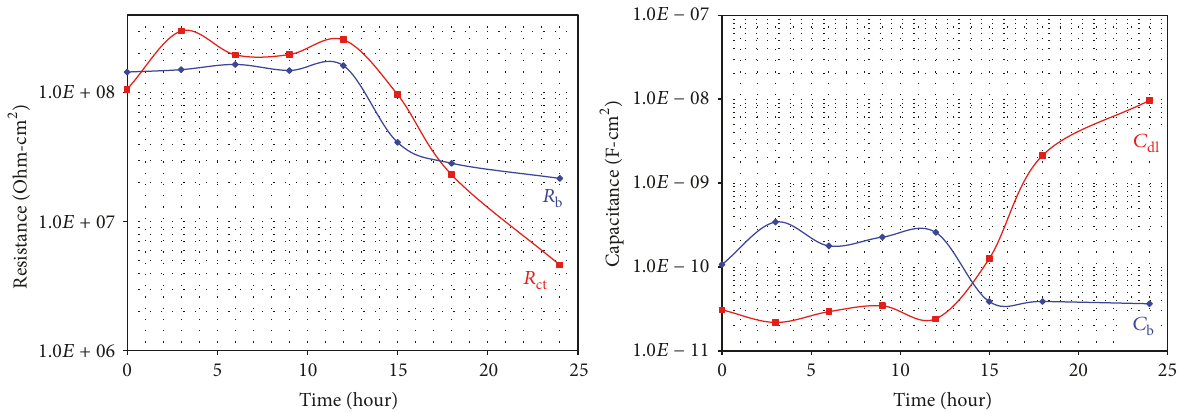
Figure 7: Electrochemical parameters extracted from the impedance